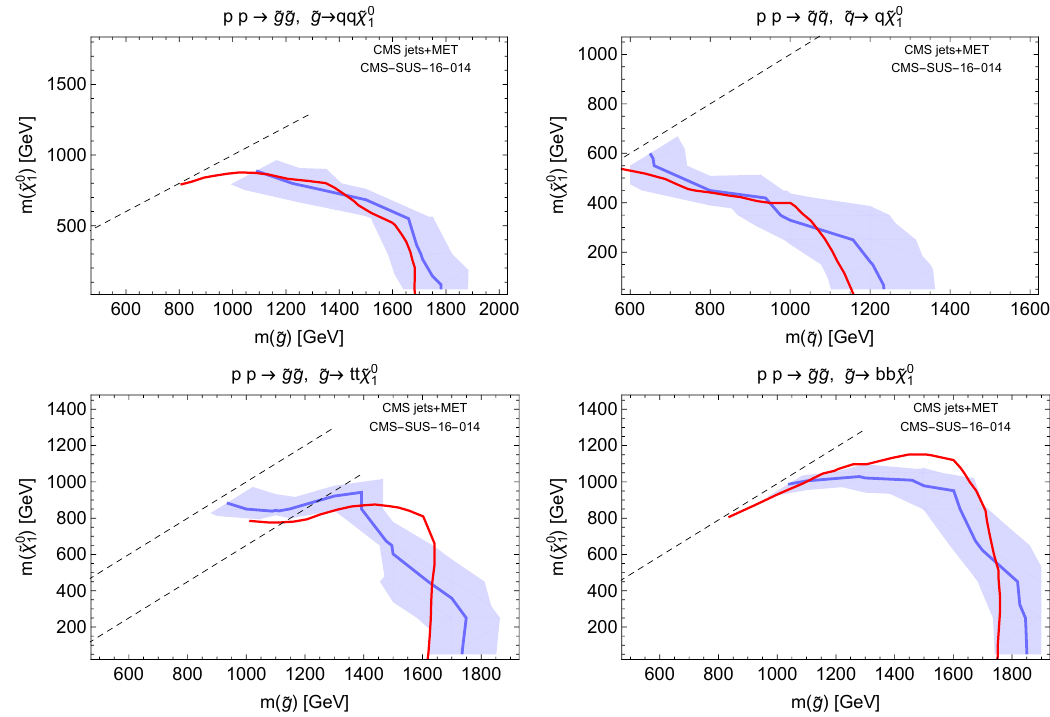
Figure 13 . Limits on supersymmetric simpli(cid:12)ed models from our recasted search of [52] (blue lines) with 50% error on the number of events in the signal regions (blue shaded regions), compared to the experimental results (red